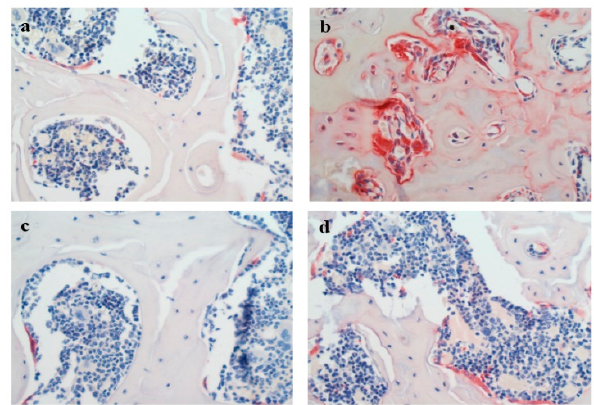
Figure 8. E ff ect of RPP on TRAP-positive cells formation in bone tissues of rats(magnification 400 × ). The osteoclasts were stained in red. ( a ) NC group; ( b ) MC group (rats treated with 75 mg / kg retinoid acid); ( c ) positive control (PC) group (retinoid acid treated rats with 5 mg / kg alendronate); ( d ) RPP group (retinoid acid treated rats with 20 mg / kg RPP).